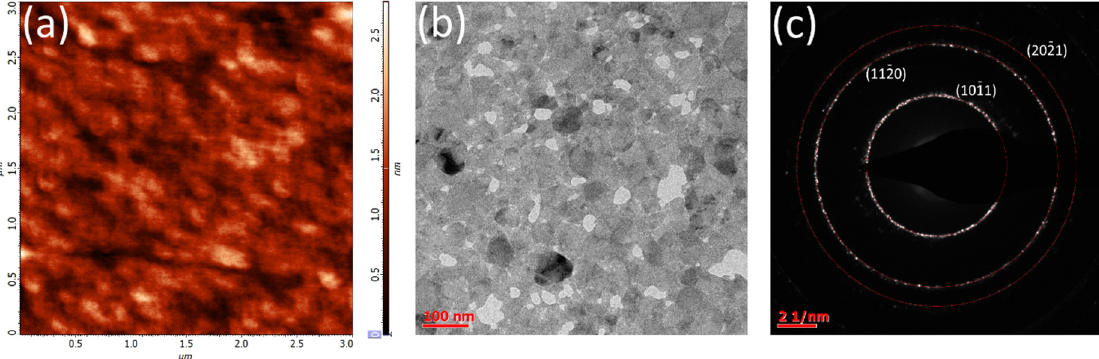
Figure 4. AFM ( a ) and plan-view TEM ( b ) images and selected-area electron diffraction (SAED) pattern ( c ) of MoS 2 film, obtained via MoO 3 sulfurization.